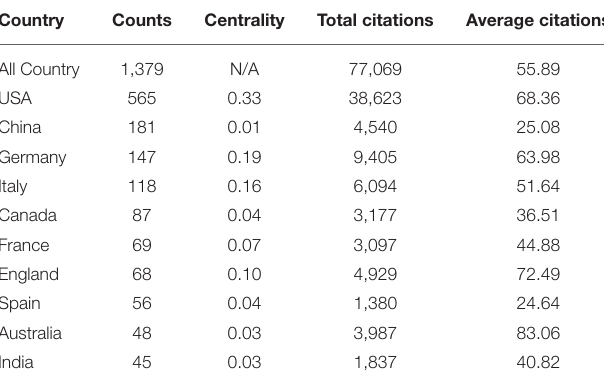
TABLE 1 | Countries and regions’ publication number, centrality, and citations. Country